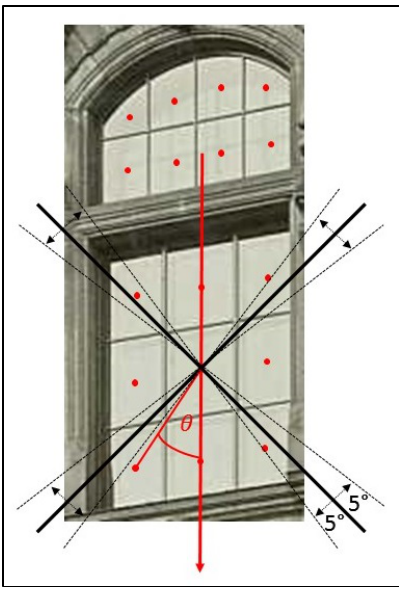
Figure 5. Example for an observed quadrilateral and its 16 neighbours represented with red dots marking the centroids. The quadrilaterals in the neighbourhood lie in different quadrants. Figure 5 shows an example of an observed quadrilateral and its 16 neighbours. Some of the quadrilaterals fall into two quadrants and consequently increment both descriptor values by 1 (eq.